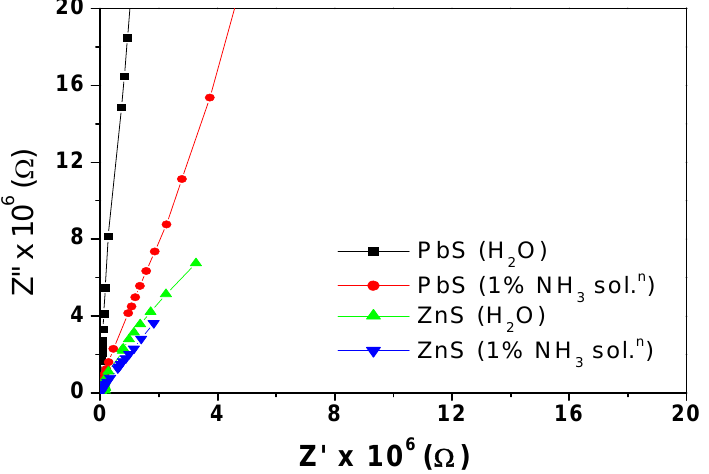
Figure 8. (a) Variation of impedance and (b) capacitance with frequency of polymer electrolyte based TEMPOS structures on exposure to water and also to 1% NH